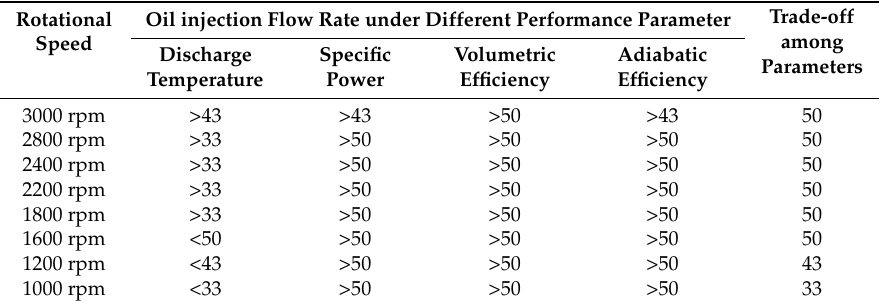
Table 3. Optimal oil injection flow rate based on different performance